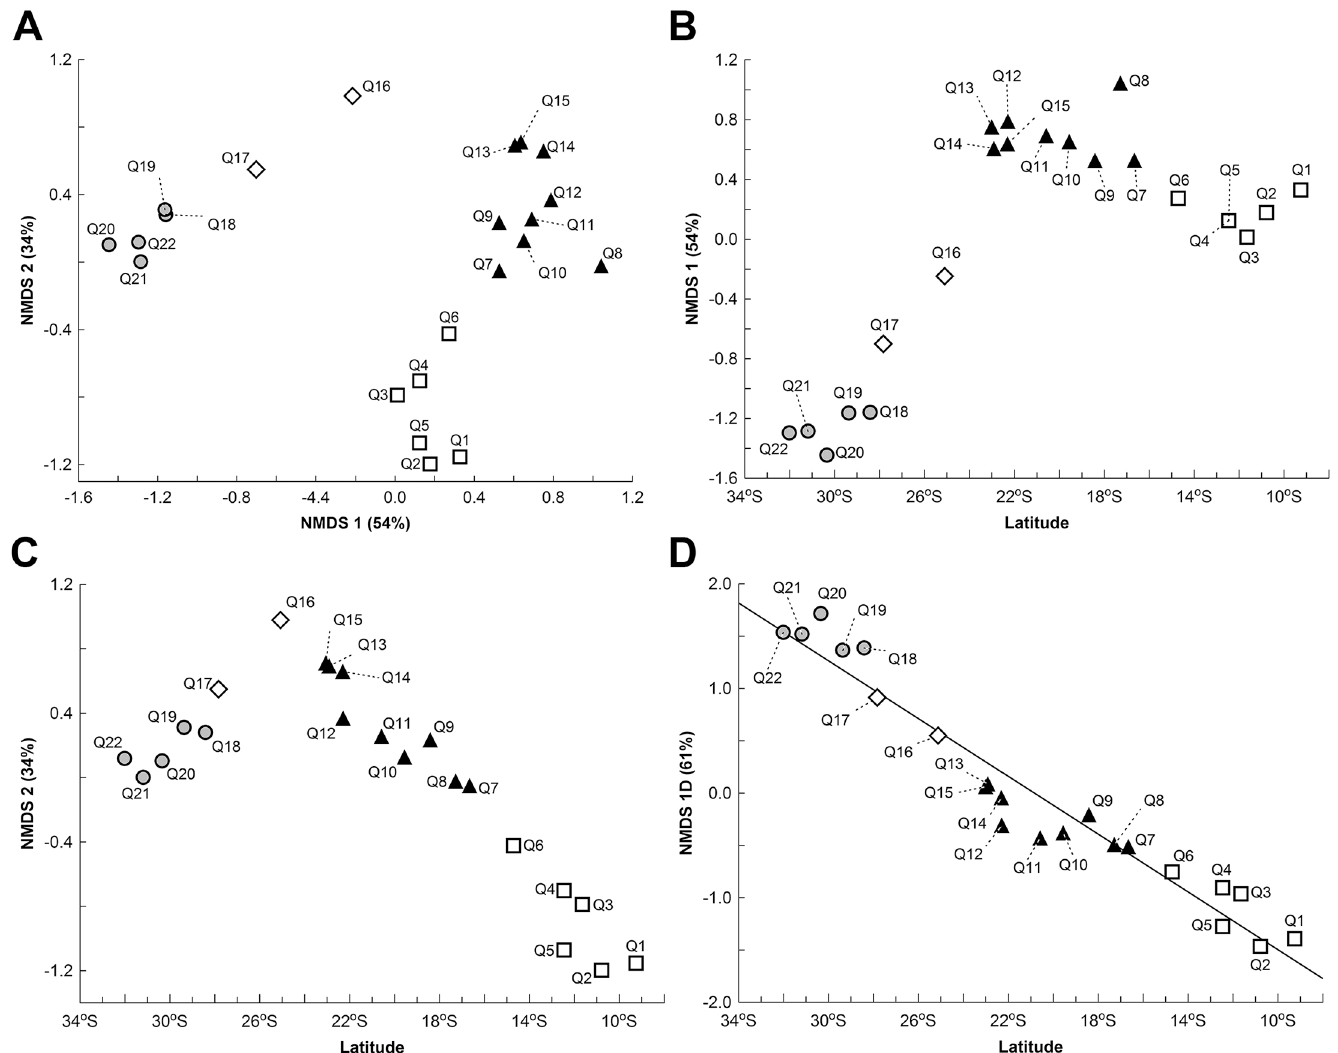
Fig 3. Projection of individual scores resulting from the non-metric multidimensional scaling method (NMDS) for 22 quadrats (sample units). Two- dimensional NMDS solution: (A) NMDS 1 vs. NMDS 2; (B) NMDS 1 vs. latitude; and (C) NMDS 2 vs. latitude. (D) One-dimensional NMDS solution: NMDS vs. latitude; the trend line was obtained from linear regression analysis (F (1,20) = 323.52, R 2 = 0.94, P < 0.0001). Symbols represent the three main groups resulted from the analysis and that are congruent with biotic elements identified in this study (see Fig 4 for biotic elements): square, northeast biotic element (BE-NE); triangle, southeast biotic element (BE-SE); circle, south biotic element (BE-S); diamond, not included in biotic